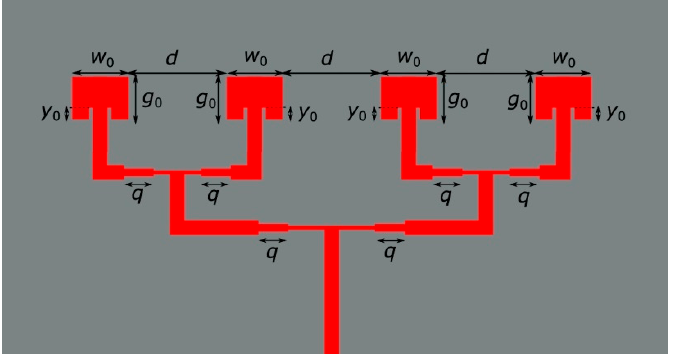
Figure 2. Patch antenna array design for the frequencies of 11.5 and 34.5 GHz—Top view.